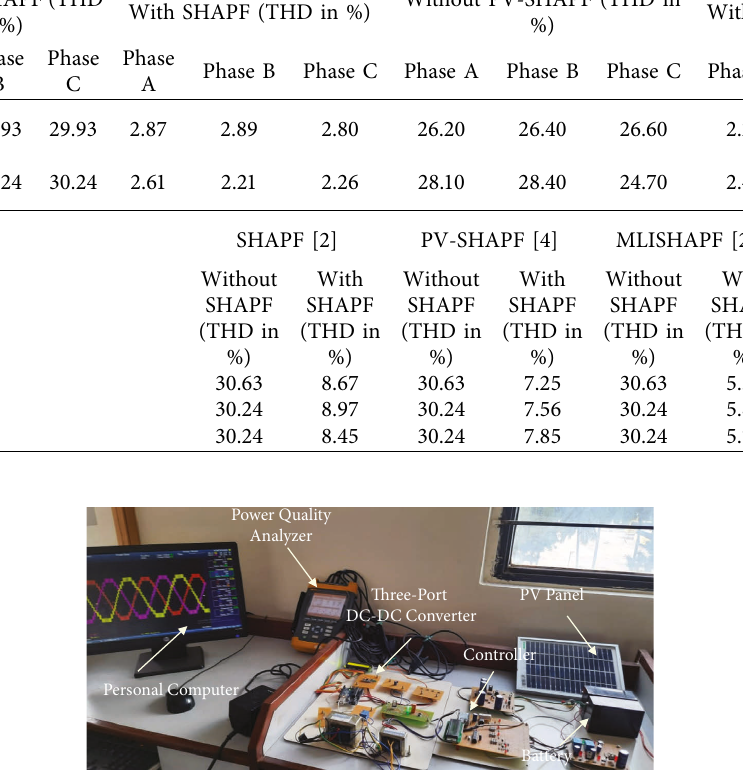
Figure 23: Photography of the experimental